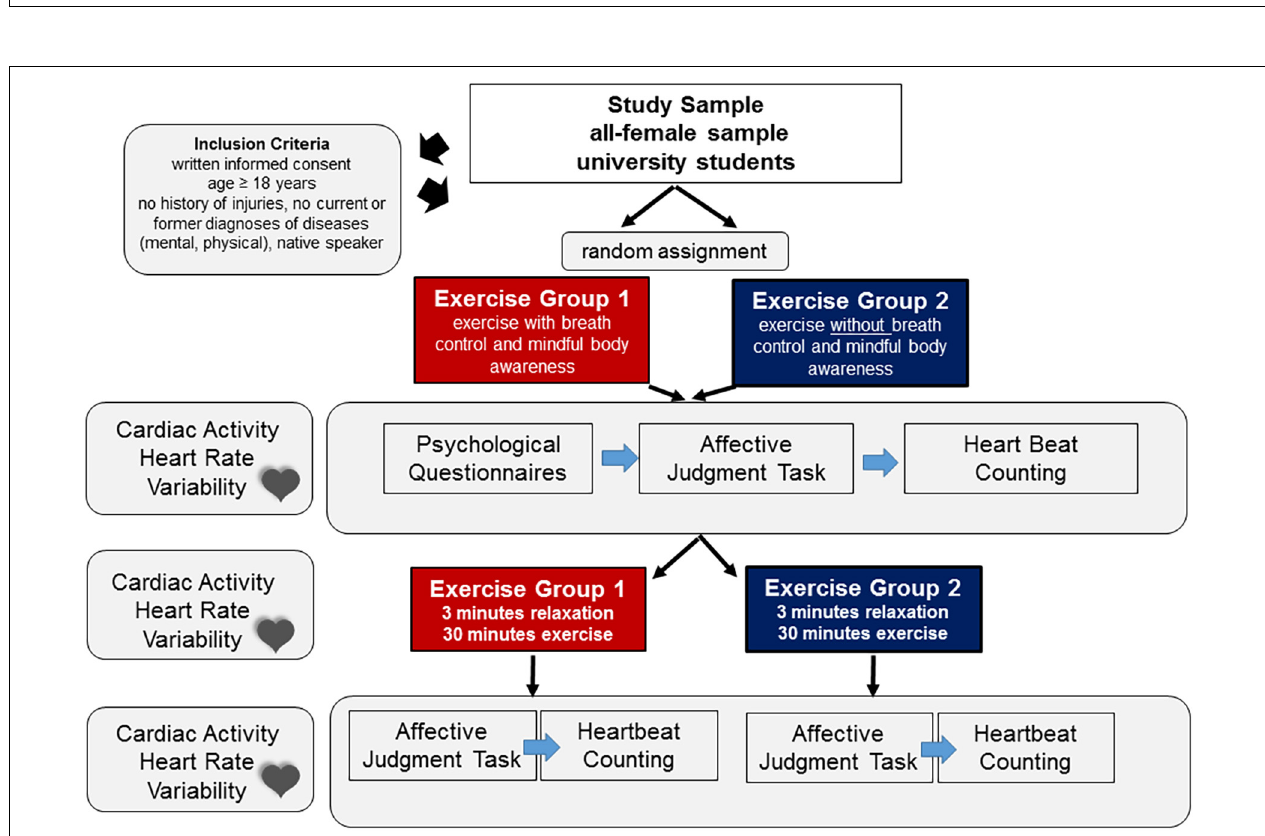
FIGURE 1 | llustration of the affective HisMine paradigm (Herbert et al., 2011). For details, please refer to the text.